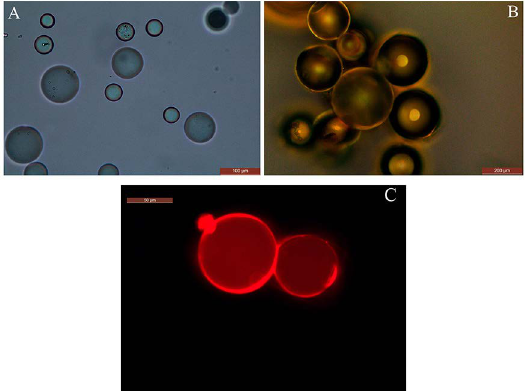
Figure 1. Optical images of A) PVA/PVAc-Rhodamine microspheres, B) PVA/ PVAc microspheres and C) Fluorescence microscopy images of PVA/PVAc-Rhodamine